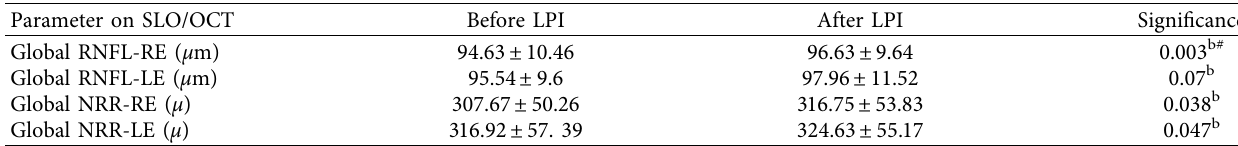
Table 3: Changes in global retinal nerve fiber layer (RNFL) and global neuroretinal rim (NRR) thickness on OCT before and after the laser peripheral iridotomy.